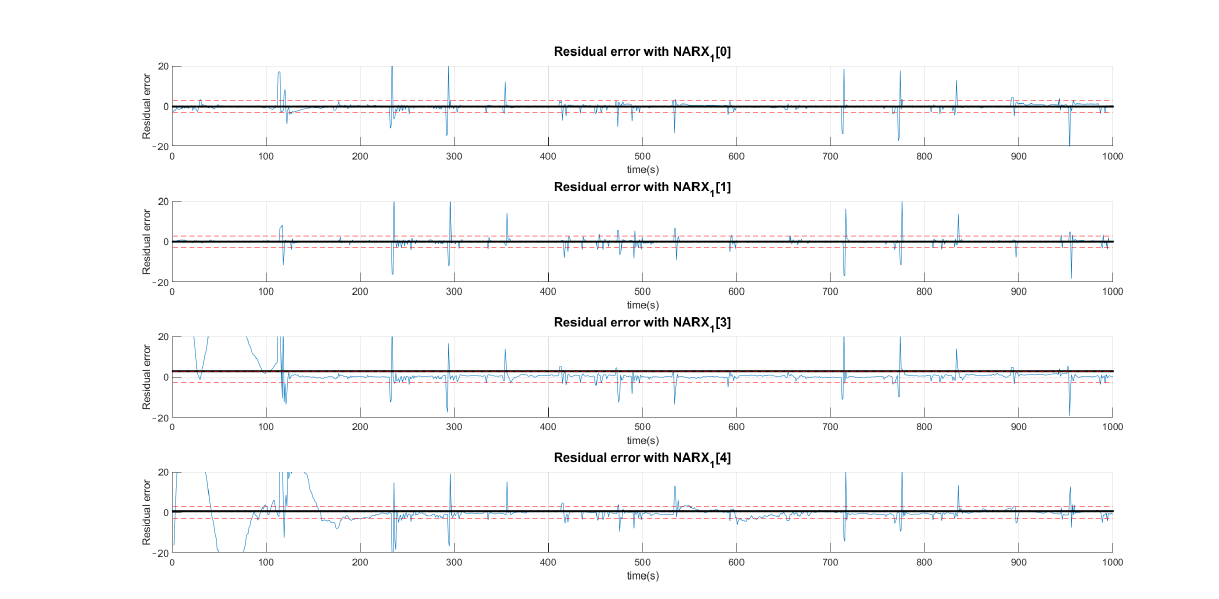
Figure 14. Residual analysis with the second layer of the network excluding those that did not have limits close to zero in the first layer. In this excerpt, residual values are presented for the situations: no faults (NARX 1 [0]), Faults F1, F3 and F4.